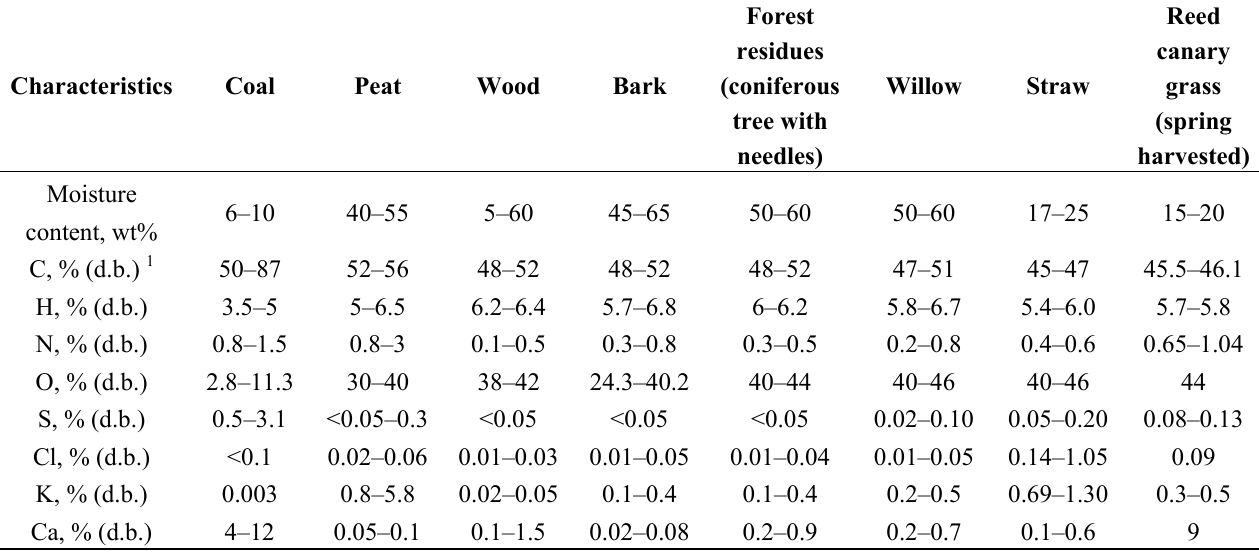
Table 1. Typical characteristics of solid fuels